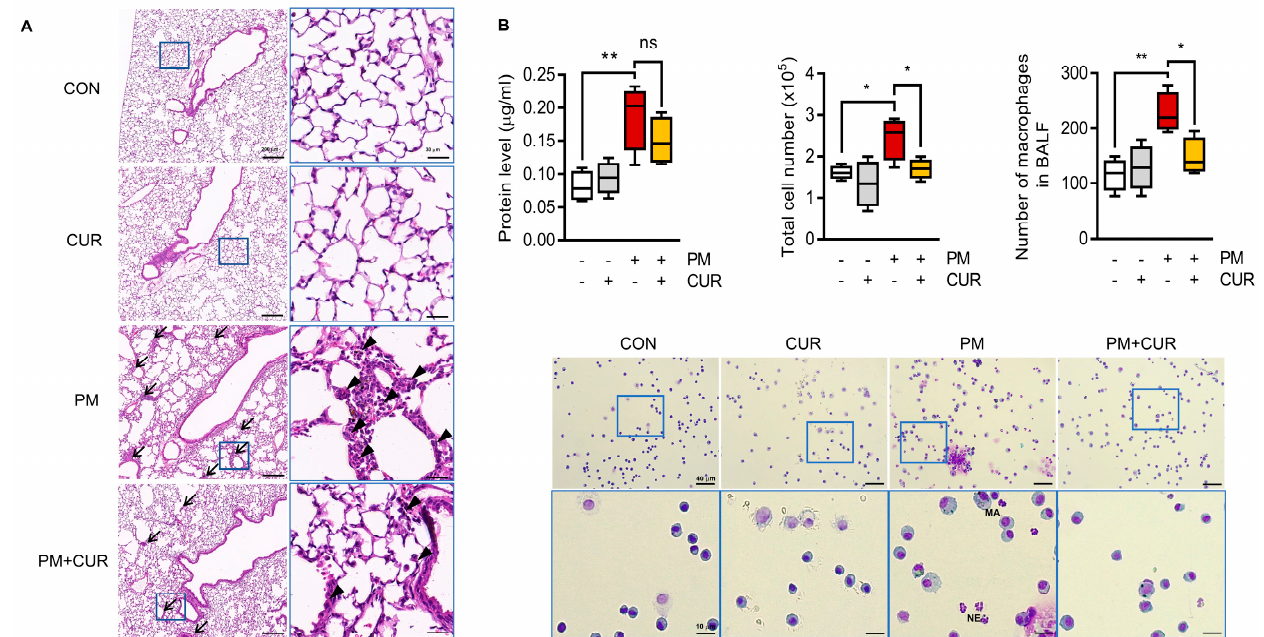
Figure 1. Curcumin alleviated histological change and immune cell infiltration in PM-treated mice lung tissue and BALF. ( A ) Effect of curcumin on pathohistological changes after bronchial administration of PM or saline. Mice were euthanized and lung tissues were stained with H&E to observe inflammatory aspects. Images show low- ( left ; scale bars, 200 µ m) and high-power magnification ( right ; scale bars, 30 µ m). Inflammatory foci marked with arrow and infiltrated immune cells marked with arrowhead. ( B ) BALF were harvested for quantification of protein concentration and total cell number. The ratio of macrophages to total cells was determined after Giemsa staining. Images show 100 × (upper; scale bars, 40 µ m) and 400 × magnification (lower; scale bars, 10 µ m). ** p < 0.01, * p < 0.05, and ns (not significant) indicates p ≥ 0.05 vs. PM-treated group. CON, control group; CUR, curcumin; PM, particulate matter (n = 6 per group).